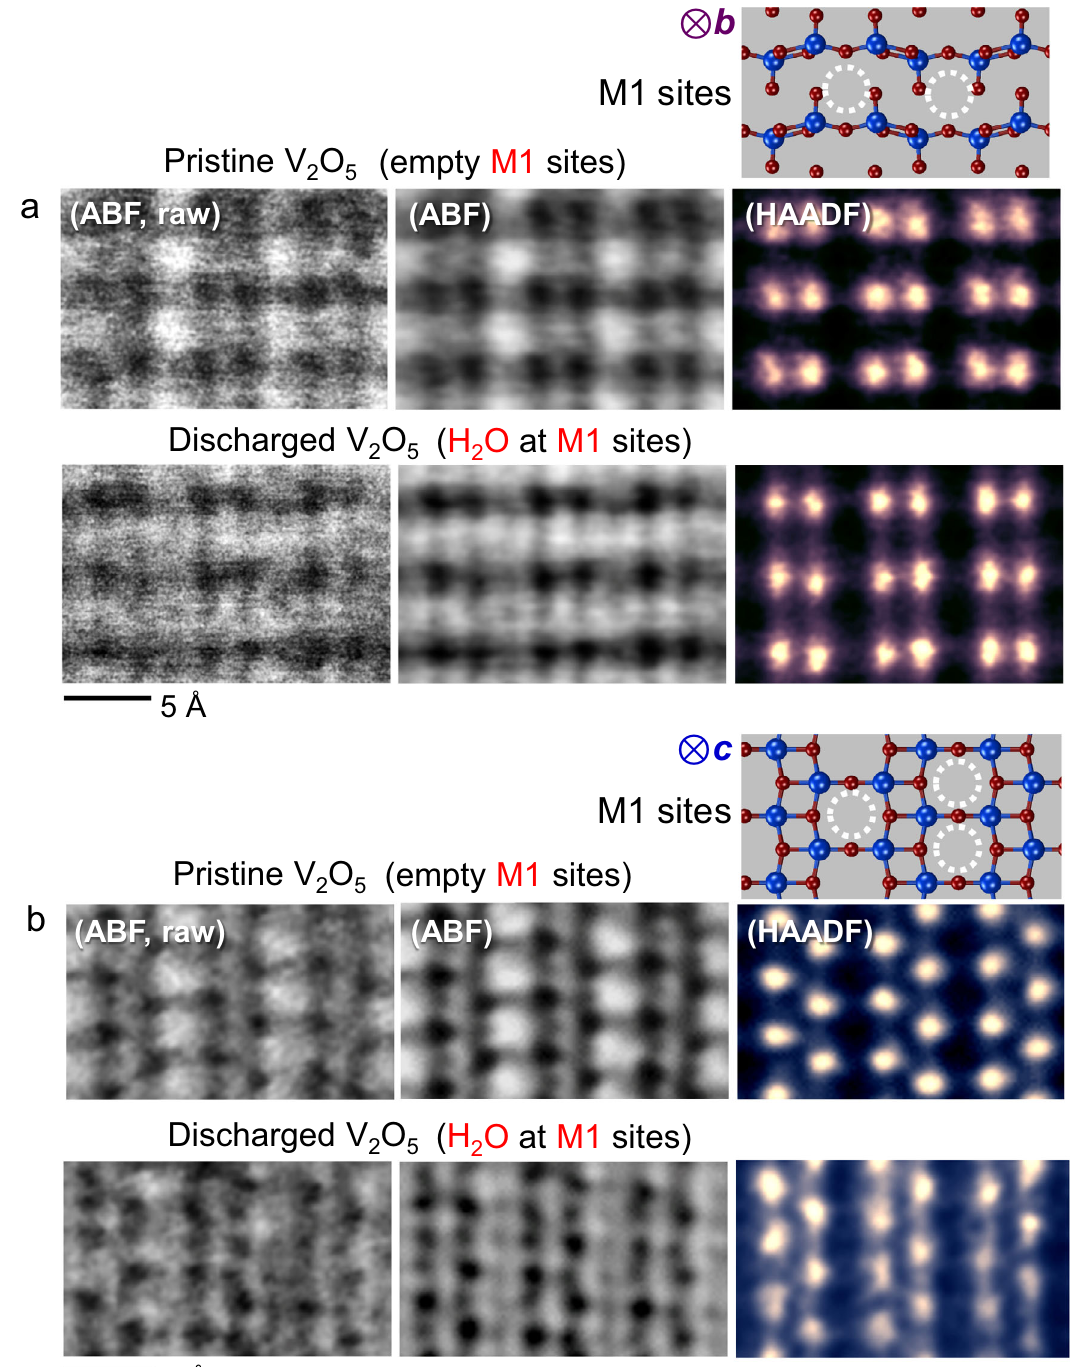
Fig. 4 STEM images in two projections to visualize the presence of H 2 O. a When neither Zn nor H 2 O intercalates, no additional contrast appears in either the HAADF or ABF image in this projection. A black contrast is clearly observed at the M1 sites in the ABF image of a discharged sample. This reveals the H 2 O insertion at the M1 sites. b These sets of images were acquired in the [001] projection. A substantial black contrast in the ABF image of a discharged sample consistently demonstrates the presence of H 2 O at the M1 sites are fi lled with Zn at location 4 as a solid solution. The for the polymorphisms). Yellow arrows in the images for rocksalt-type VO structure in both projections is also found in location 4 denote intercalated Zn in the interstitial sites in the location 5. As reported in a recent study on a vanadium oxide 53 VO 2 (A)-type structure. On the basis of the atomic con fi gura- in addition to other Li-intercalated metal oxides 26,27,30 , the tion in the images of locations 3 and 4 in both projections, the rocksalt structure having cations in every octahedral site in the crystal structure of locations 3 and 4 appears to be basically an close-packed oxygen-anion framework appears to be a local identical VO 2 (A) type, showing that many of the interstitial